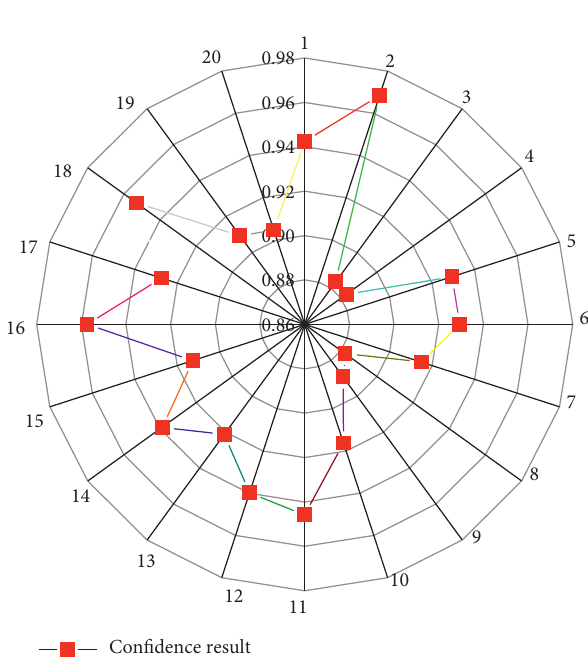
Figure 6: Construction example confidence